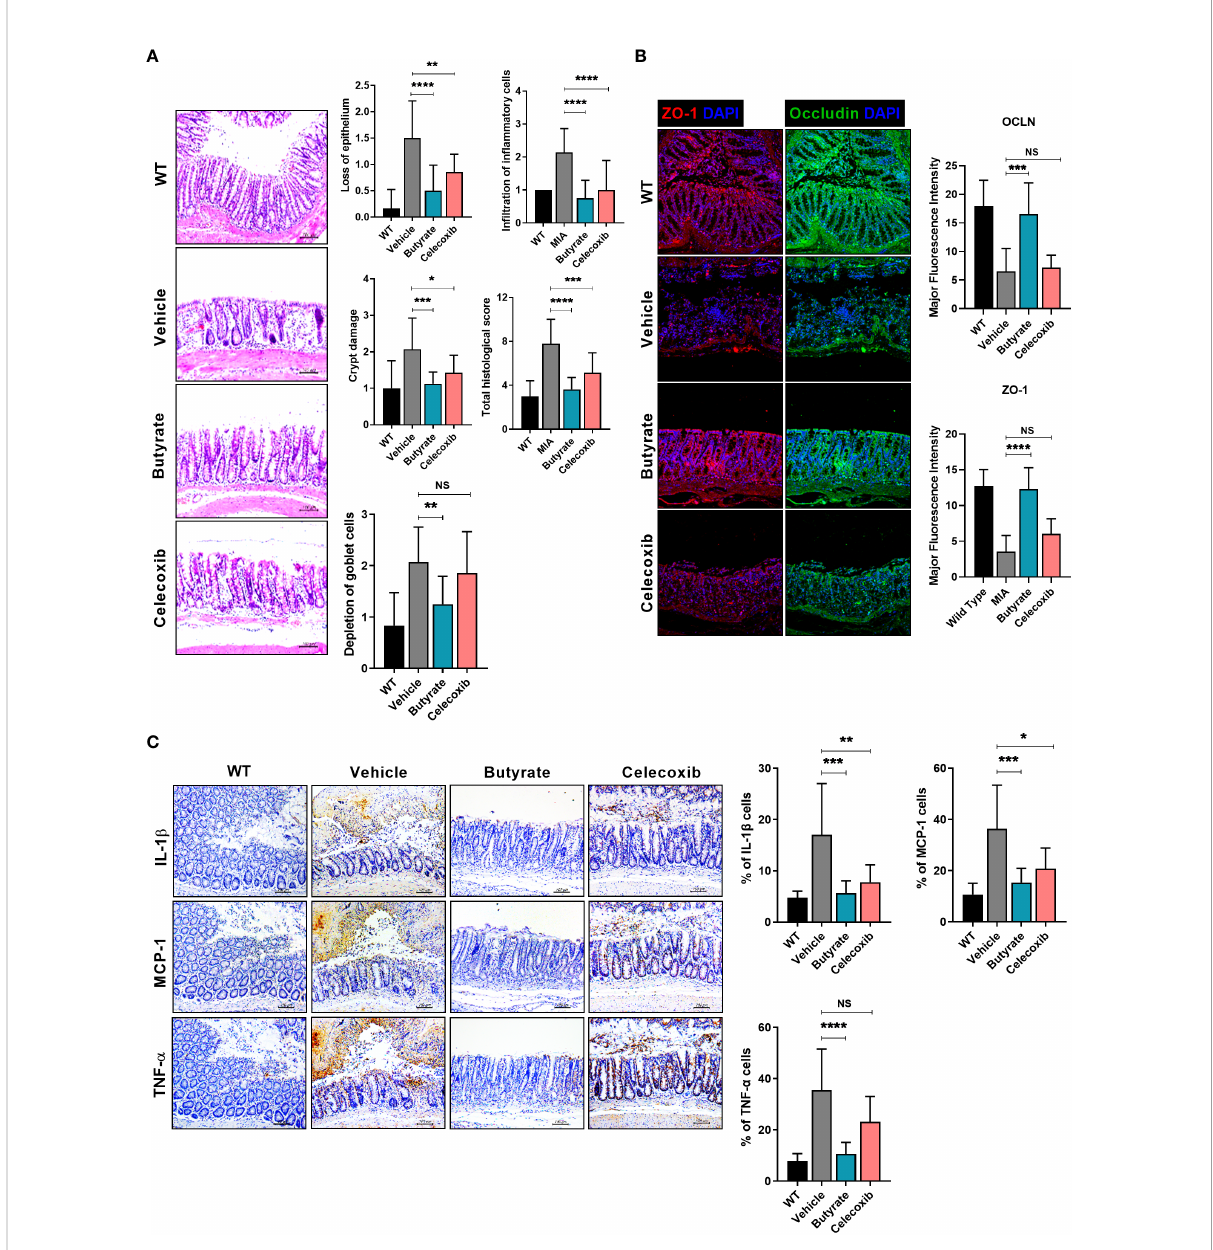
FIGURE 5 Butyrate restores tight junction proteins, inhibits intestinal damage, and reduces in fl ammatory factor levels. (A) Three weeks after MIA injection, the degree of intestinal damage in rats was evaluated by H&E staining (magni fi cation ×200). (B) Effect of butyrate on tight junction protein (TJP) expression by immuno fl uorescence staining (magni fi cation ×200). (C) Effect of butyrate on the expression levels of in fl ammatory factors in rat intestine by IHC (magni fi cation ×200). Data are means ± SD (* p < 0.05, ** p < 0.01, *** p < 0.005, **** p < 0.001), ns, not signi fi